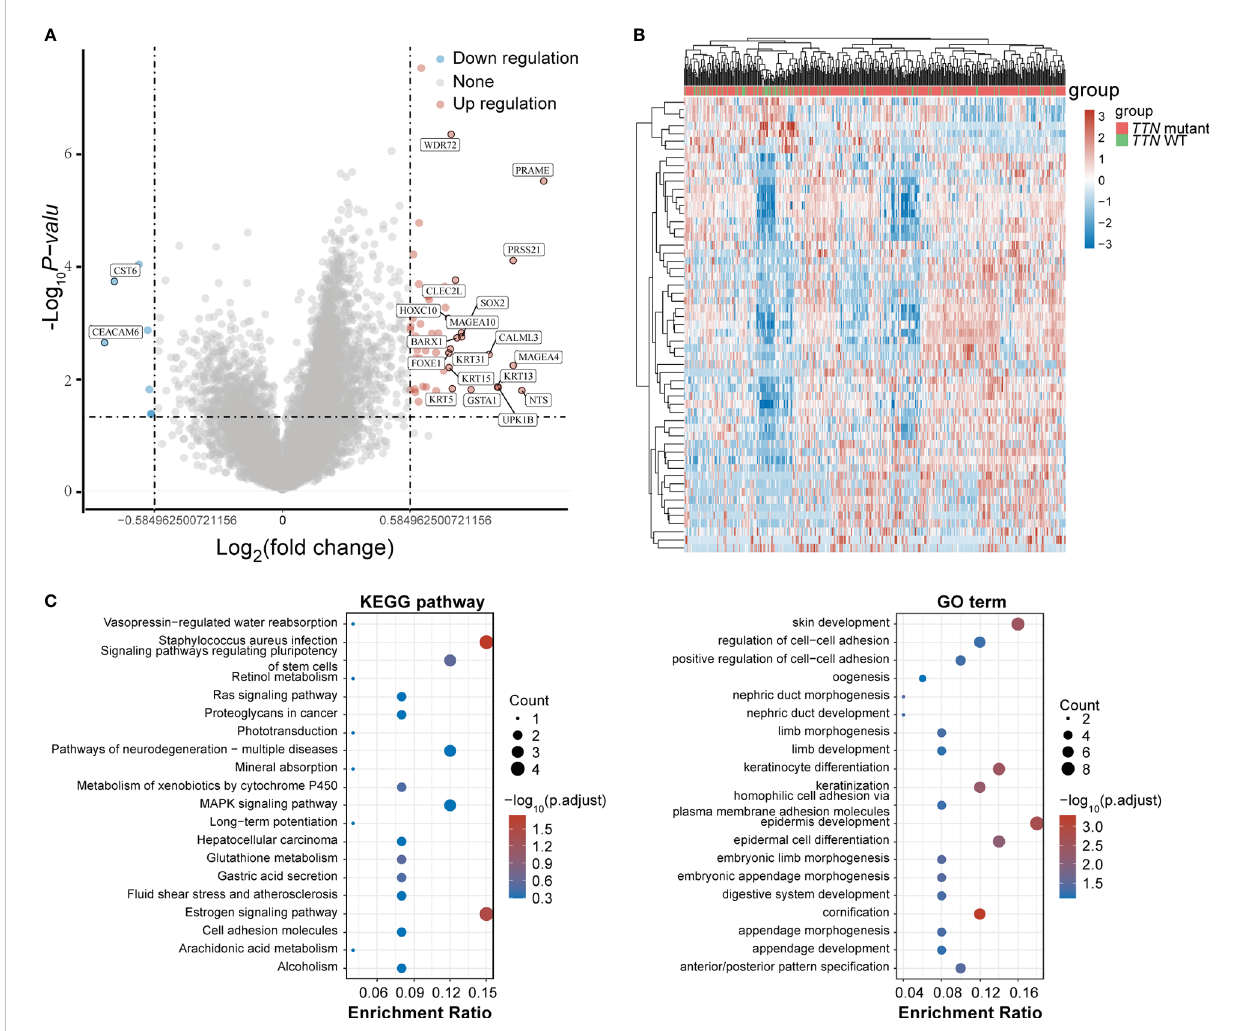
FIGURE 3 DEGs screening. (A) Volcano plot. Red dots represent signi fi cantly differentially upregulated genes, blue dots represent signi fi cantly differentially downregulated genes, and gray dots represent insigni fi cant genes. (B) Heat map of the top 50 signi fi cantly DEGs. Different colors represent expression trends in different tissues. (C) GO functional enrichment and KEGG pathway analysis of upregulated